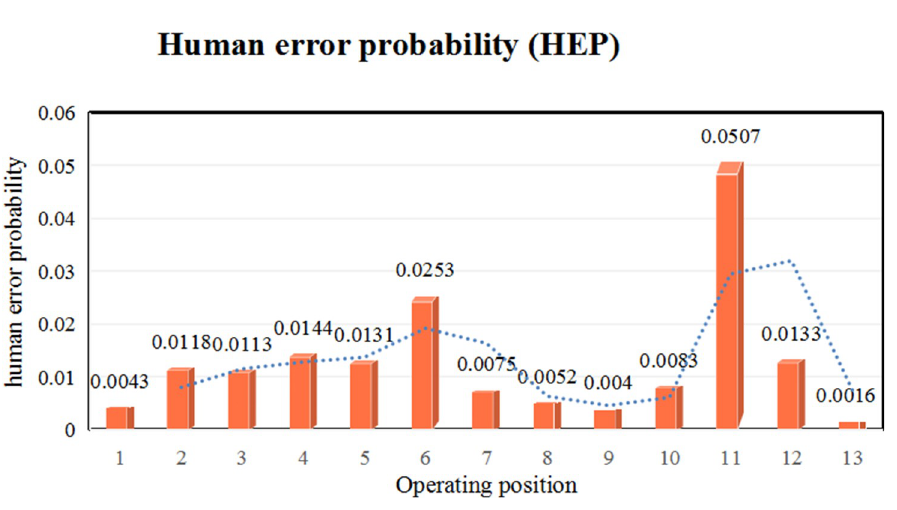
Fig 5. HEP curve at different